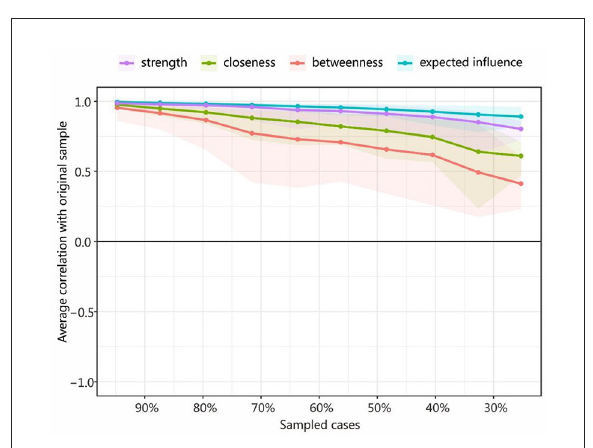
FIGURE4 Average correlations between the centrality indices of networks sampled with persons and the original sample. Lines indicate the means and areas ranging from the 2.5th quantile to the 97.5th